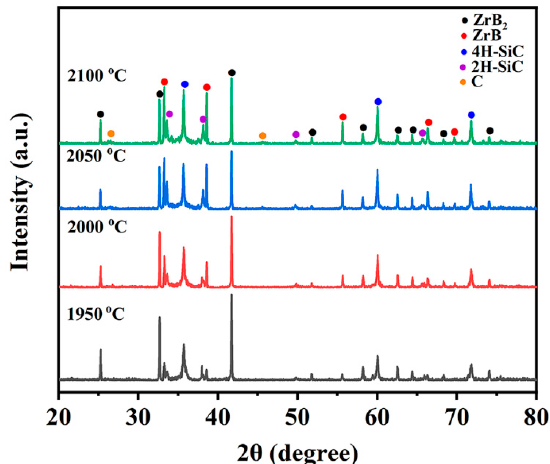
Figure 3. XRD patterns of P70Z15A15 by the variation of sintering temperatures.